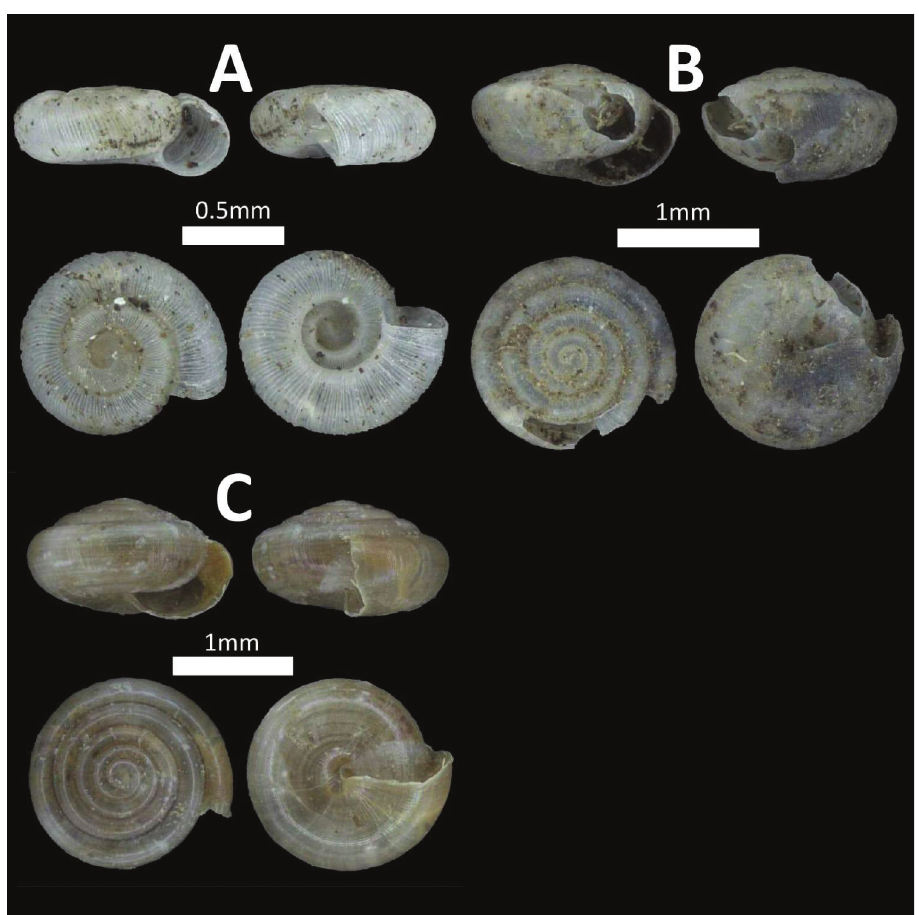
Figure 15. Family Charopidae. A Discocharopa aperta (BOR/MOL 11092) B Charopa sp